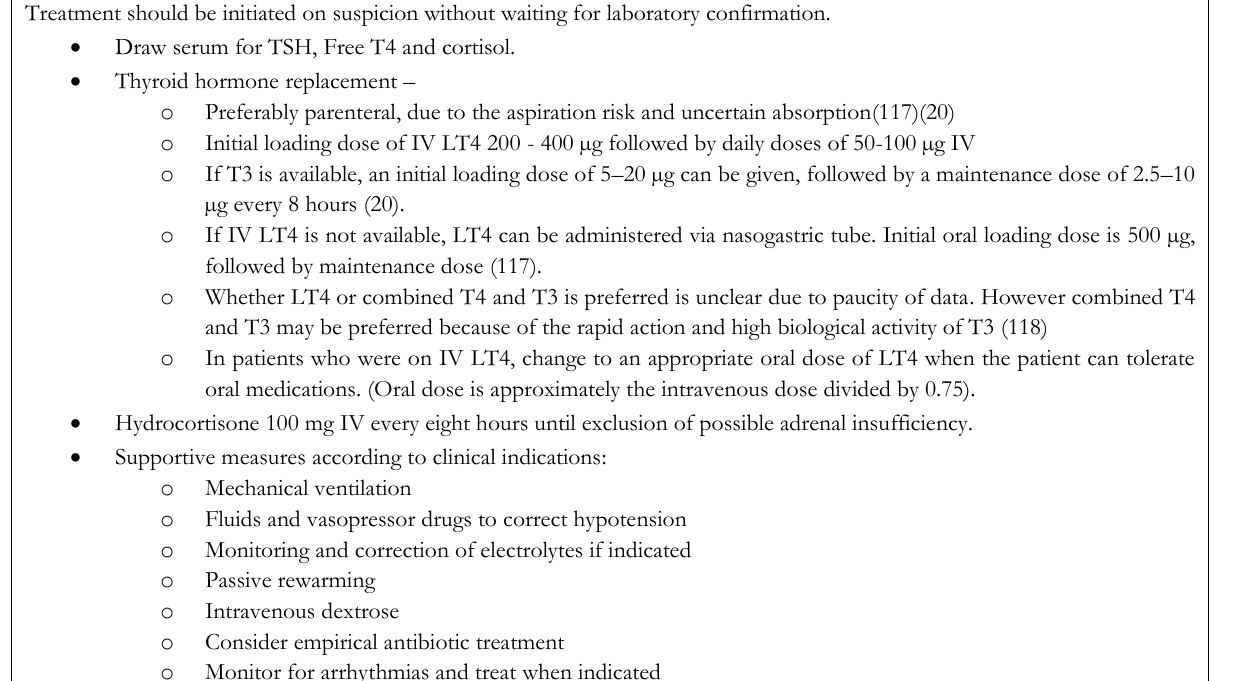
(figure 4.4). Monitor thyroid functions in post-partum thyroiditis for progression to